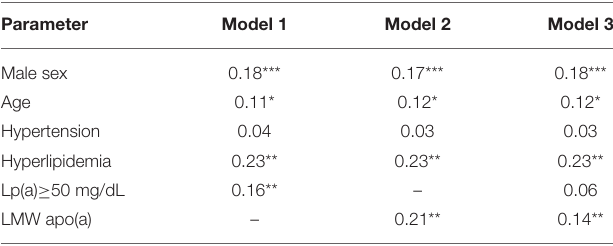
TABLE 2 | Multiple regression analysis of the relationship of lipoprotein(a) with the number of affected coronary arteries.